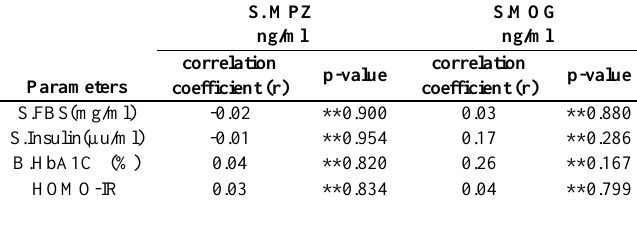
Table 3 : Correlation analysis between levels of serum MPZ and MOG for studied parameters in (T2DM with diabetes duration > 5 years) group